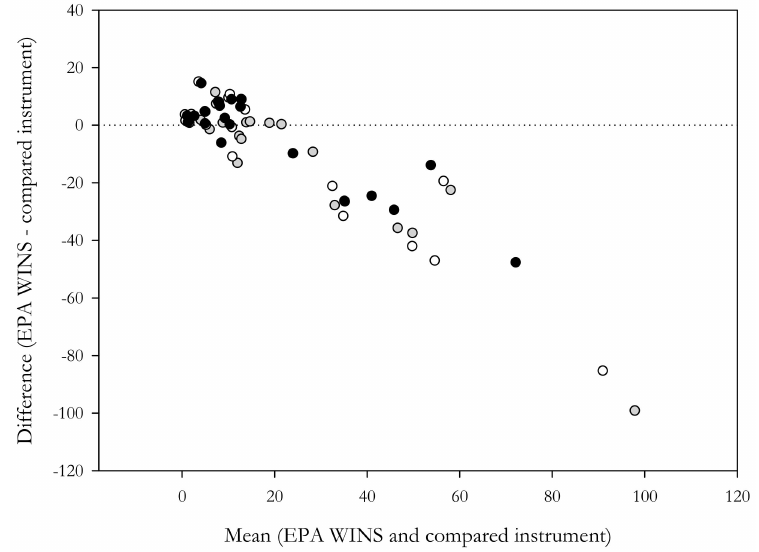
Figure 1. Bland-Altman plot for different instruments (grey: Aerocet; white: Optical Particle Counters (OPC); black: ABx). The mean concentrations between the gravimetric reference method (EPA WINS) and the compared instrument are reported on the x-axis while on the y-axis the differences between methods are shown (8-h average). The dotted line represents the perfect agreement between the two instruments (absolute deviation: